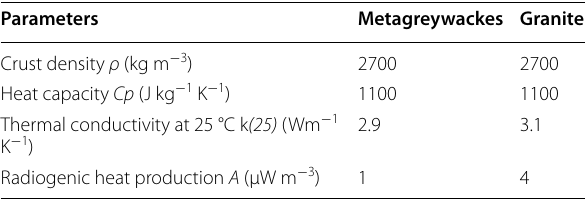
Table 2 Parameters used in the numerical models Parameters Metagreywackes Granite